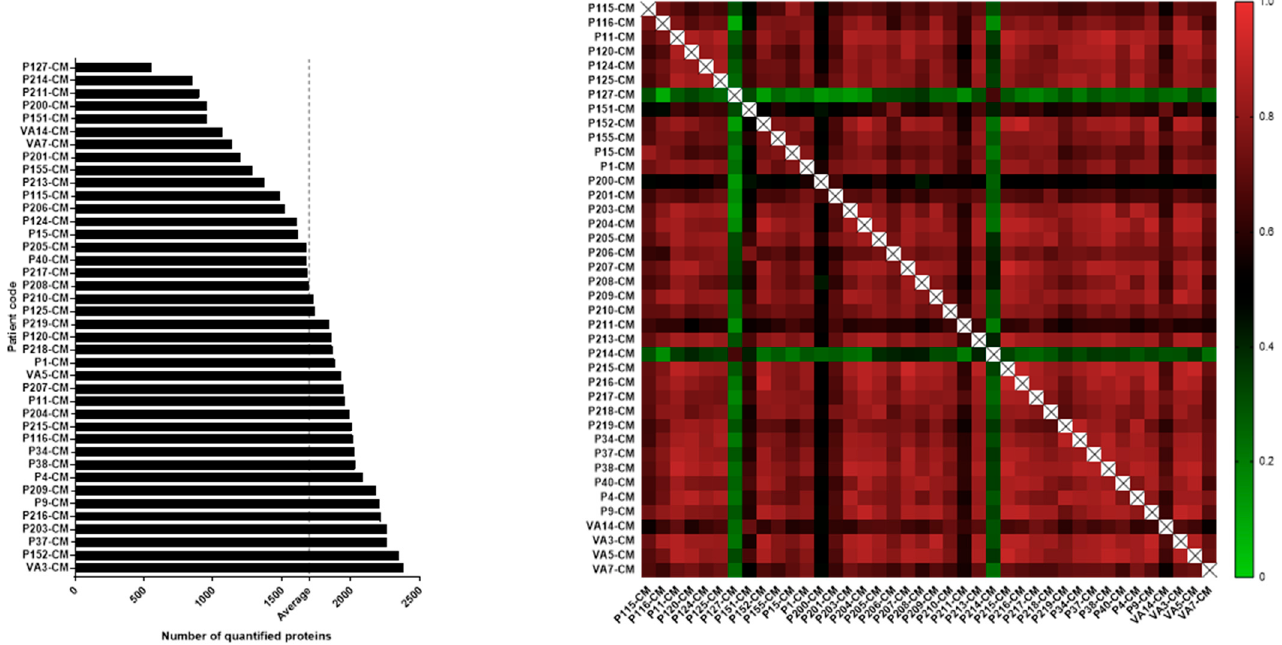
Figure 2. The heterogeneity in constitutive protein release by primary human AML cells; a comparison of leukemic cells derived from 40 patients. The cells were cultured for 48 h in serum-free medium before supernatants were harvested and the proteomic analyses performed. (Left figure) The figure presents the number of detectable proteins for each of the 40 patients. The number of quantified proteins varied from 557 to 2380 proteins (1699 proteins in average, vertical dotted line) between individual patients. (Right figure) The heatmap of the Pearson Correlation R values illustrates how well the protein expression correlates between the 40 AML patients, i.e., the patients showed a large degree of overlap with regard to the abundance of proteins released. This analysis is based on the 1770 proteins detected for at least 20 of the 40 AML-CM samples.